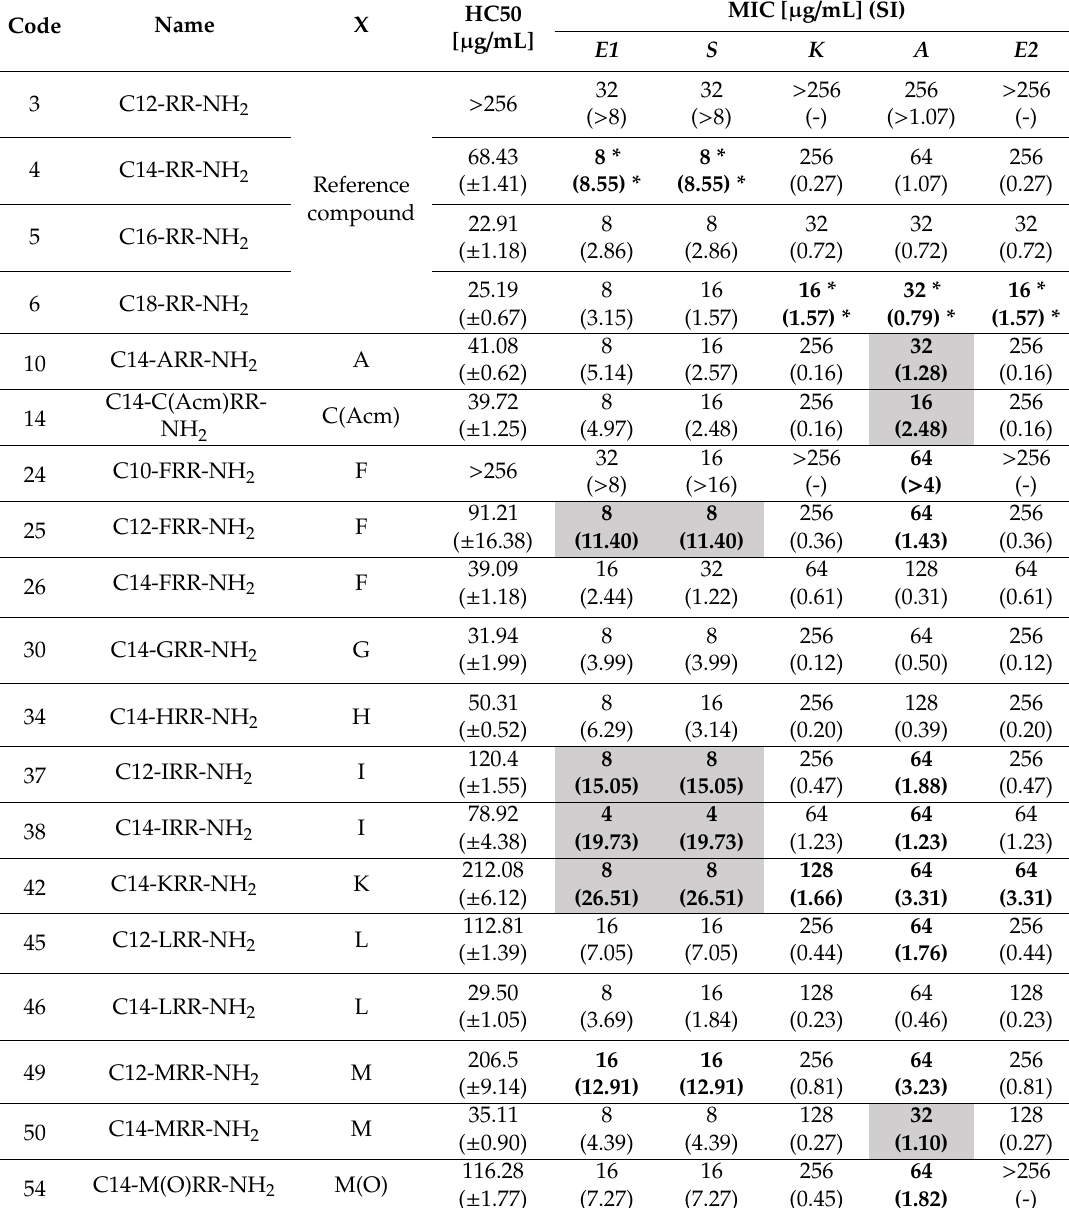
Antimicrobial activity against ESKAPE strains, hemolysis, and selectivity index of selected